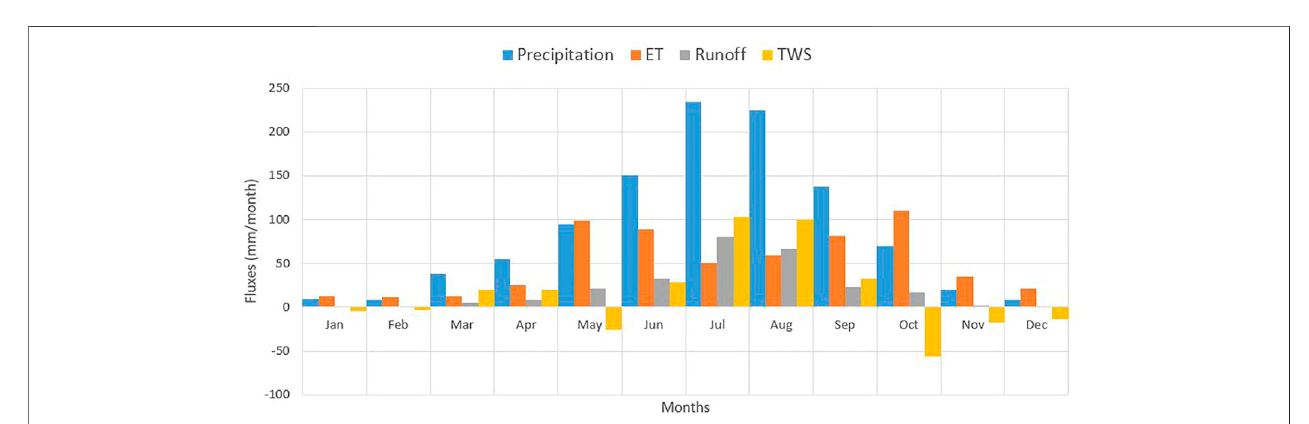
FIGURE9| Monthlymeanwater-budgetcomponentsonalong-termbasinscale.Therelativesharesofthefourcomponents(Precipitation,Runoff,ETandTWSC) are shown.